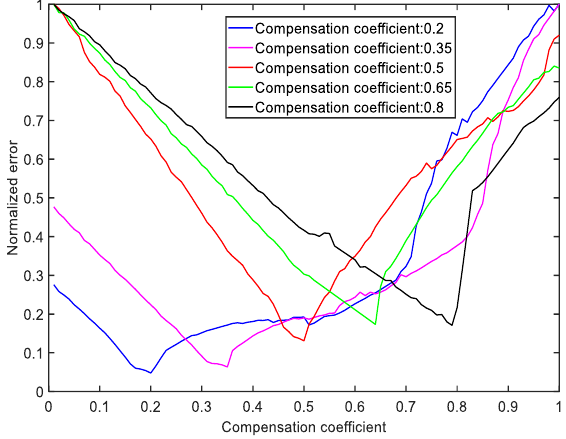
Figure 10. Normalized error of different compensation coefficients.